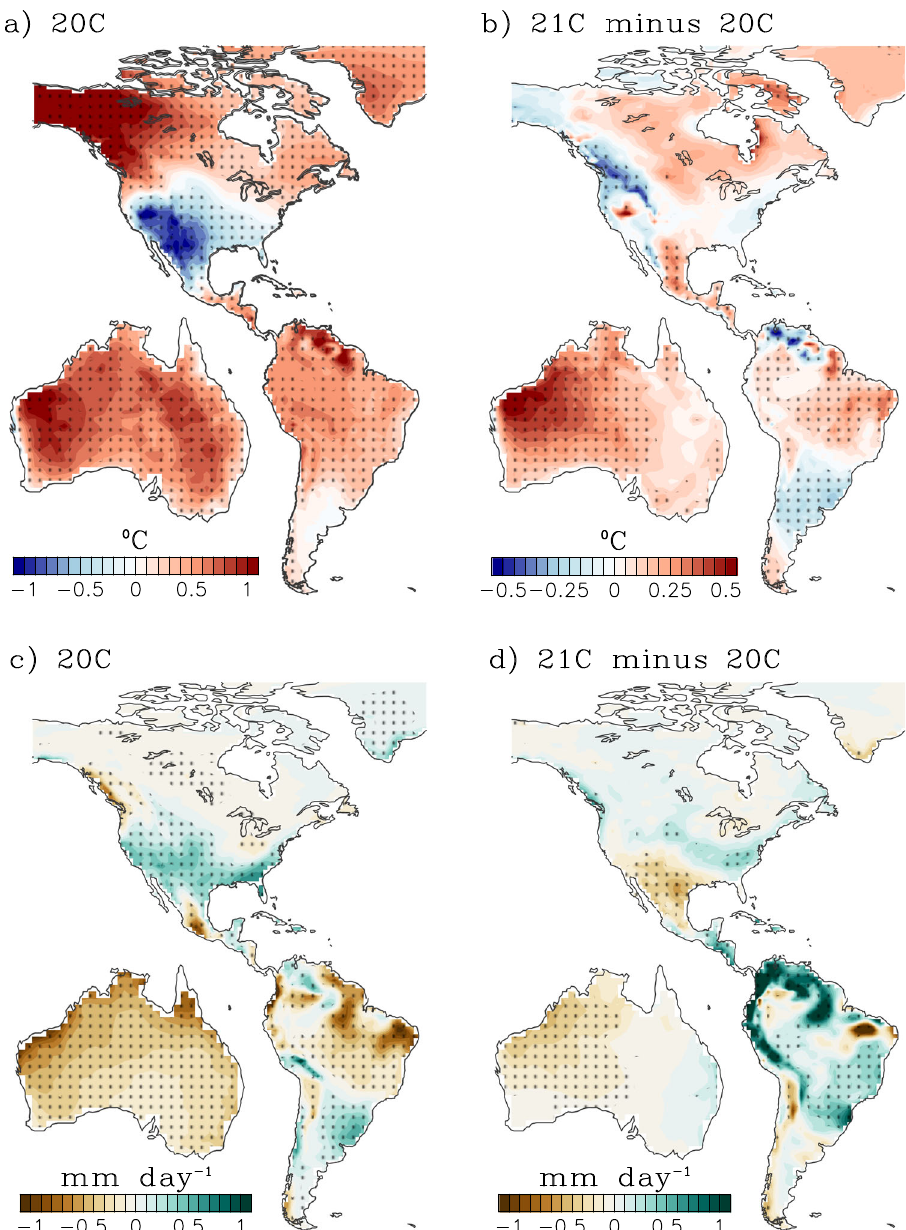
Fig. 5 Representative map depicting the remote effects of El Niño event on surface temperature and precipitation and their projected changes from CESM-LENS. a Surface temperature [blue-red, °C] and c precipitation [brown-green, mm day − 1 ] composite during March-April-May (MAM, or decay year + 1) for late 20 th Century El Niño events (see Methods for De fi nition of El Niño). Projected changes in b temperature and d precipitation composite (21 C minus 20 C) during MAM (or decay year + 1). Stipples indicate anomalies that are signi fi cant at the 95% level based on a bootstrapping technique (see